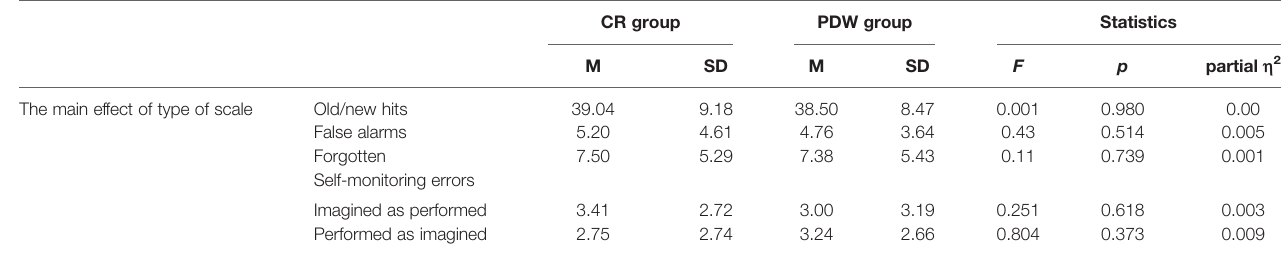
TABLE 4 | The main effect of type of scale (CR vs. PDW) on